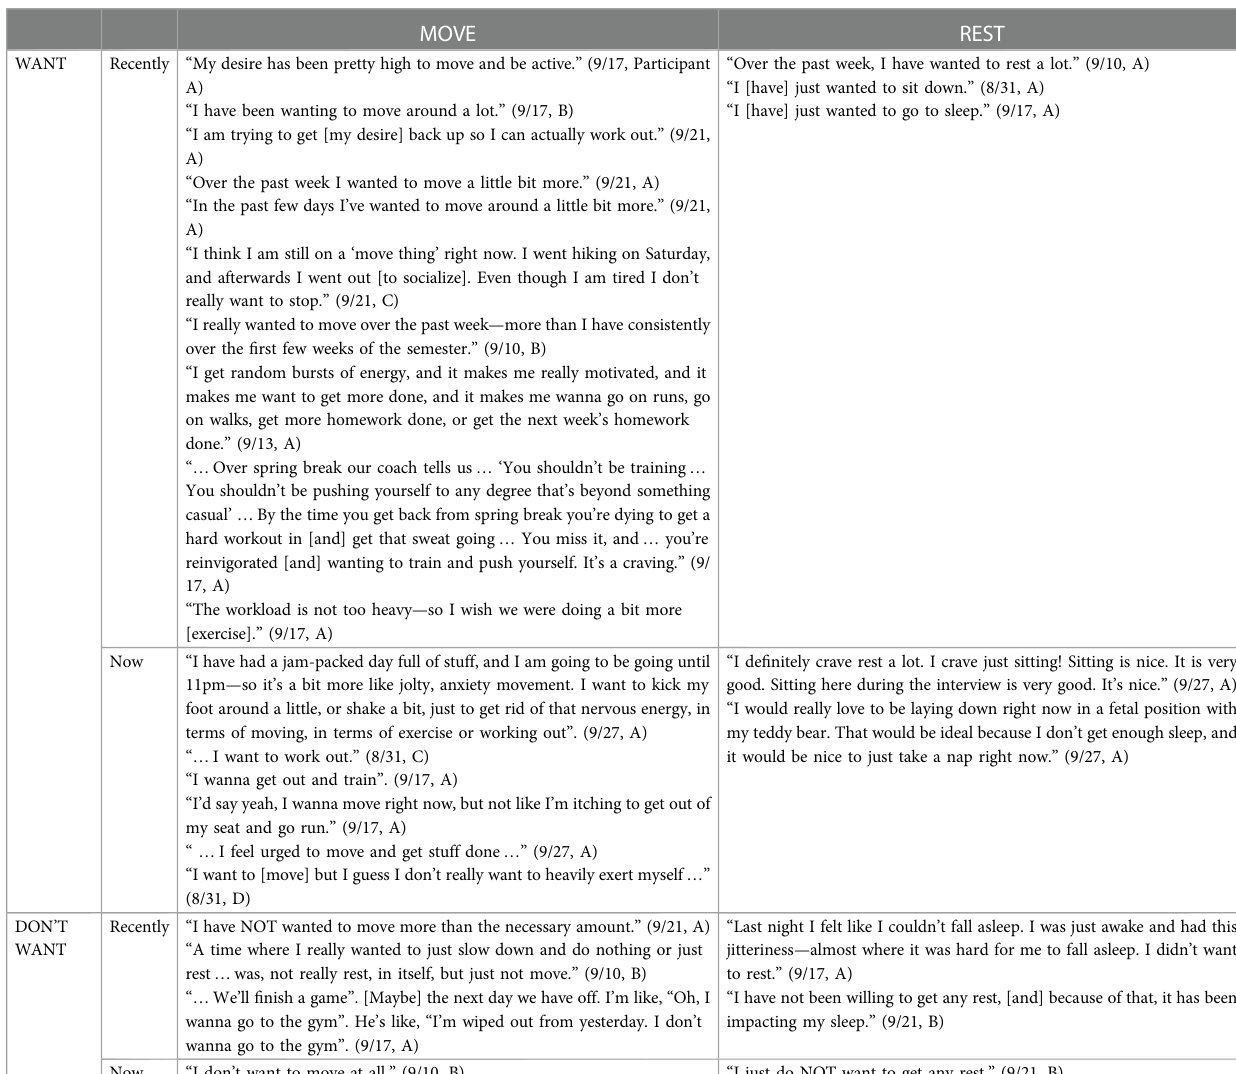
TABLE 3 Qualitative evidence for ACMS for movement/physical activity/exercise as well as rest/sedentary behaviors. a